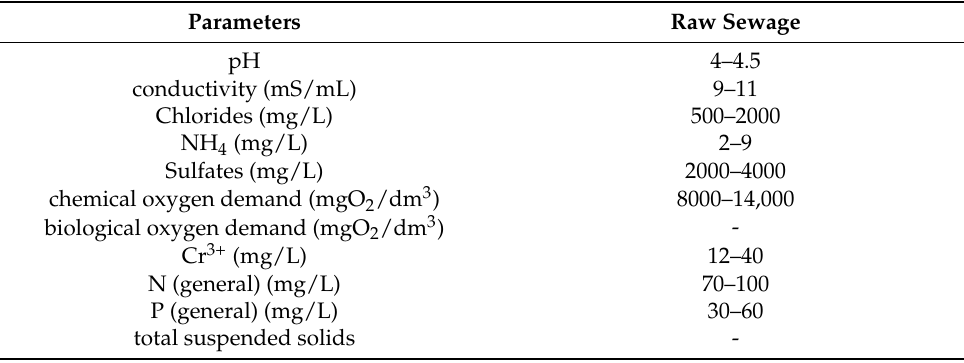
Table 5. An examples of analysis results from the dying and tanning process.